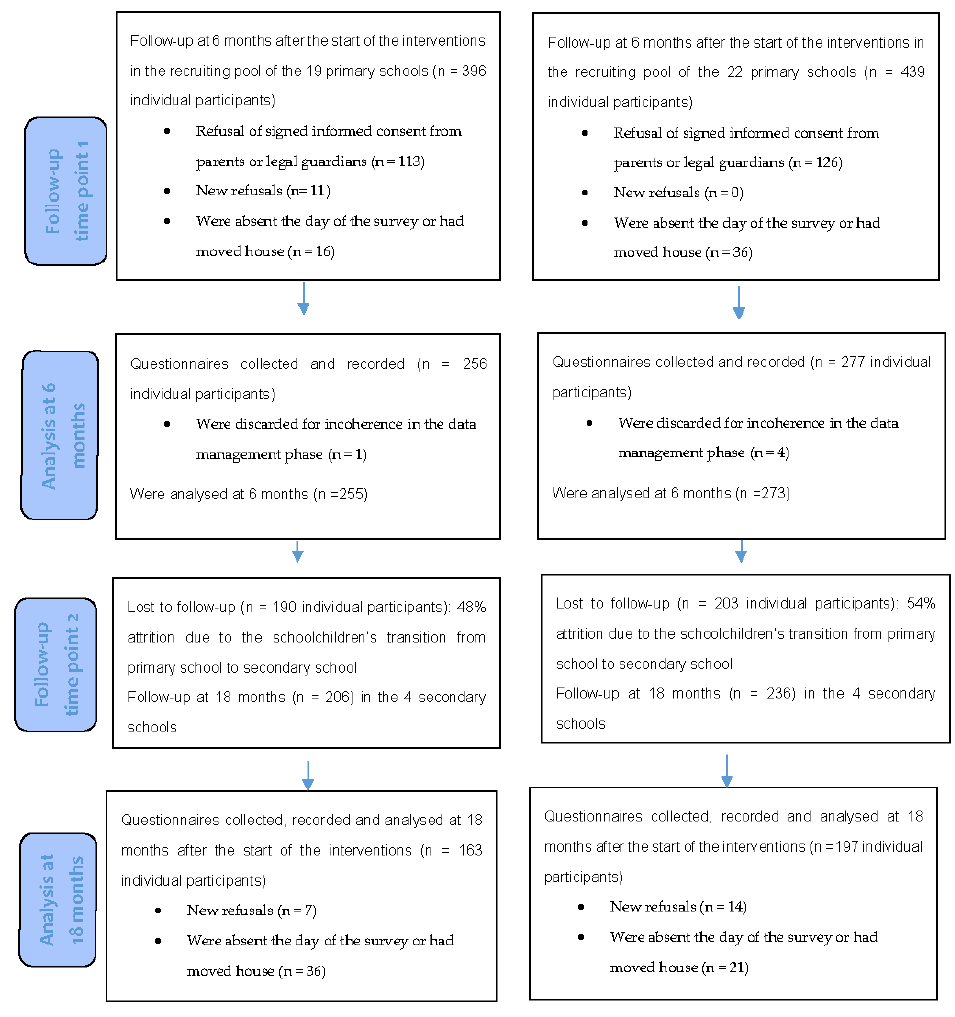
Figure 1. Flow diagram.